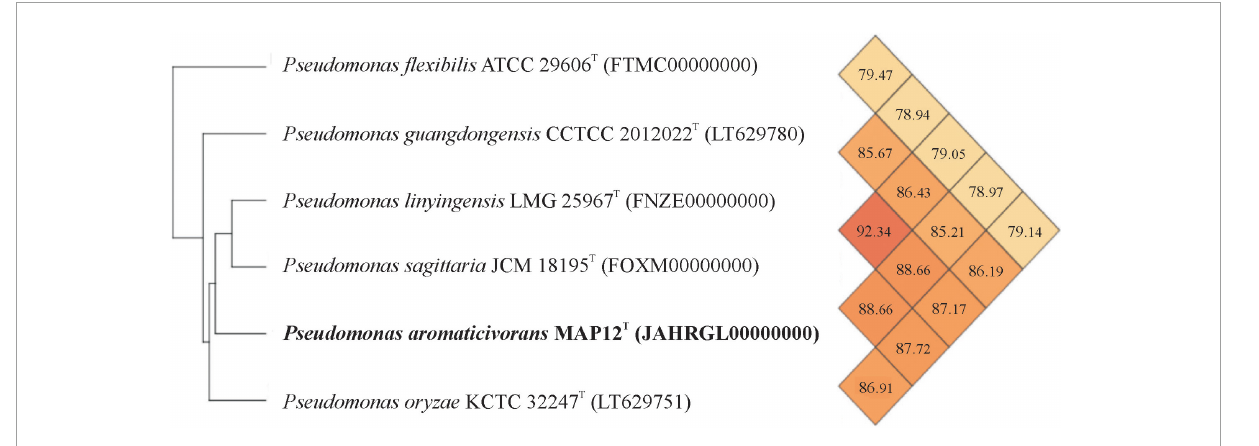
FIGURE3 Heatmap generated with OrthoANI values between strain MAP12 T and other closely related type strains of the genus Pseudomonas .